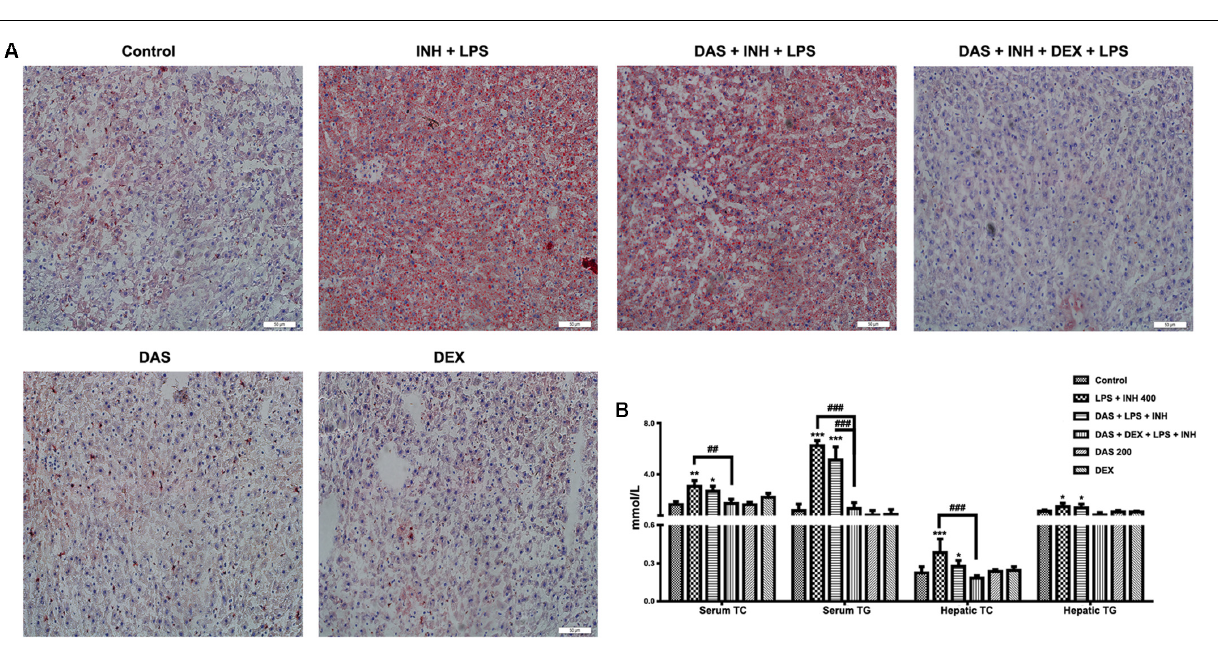
Frontiers in Pharmacology |